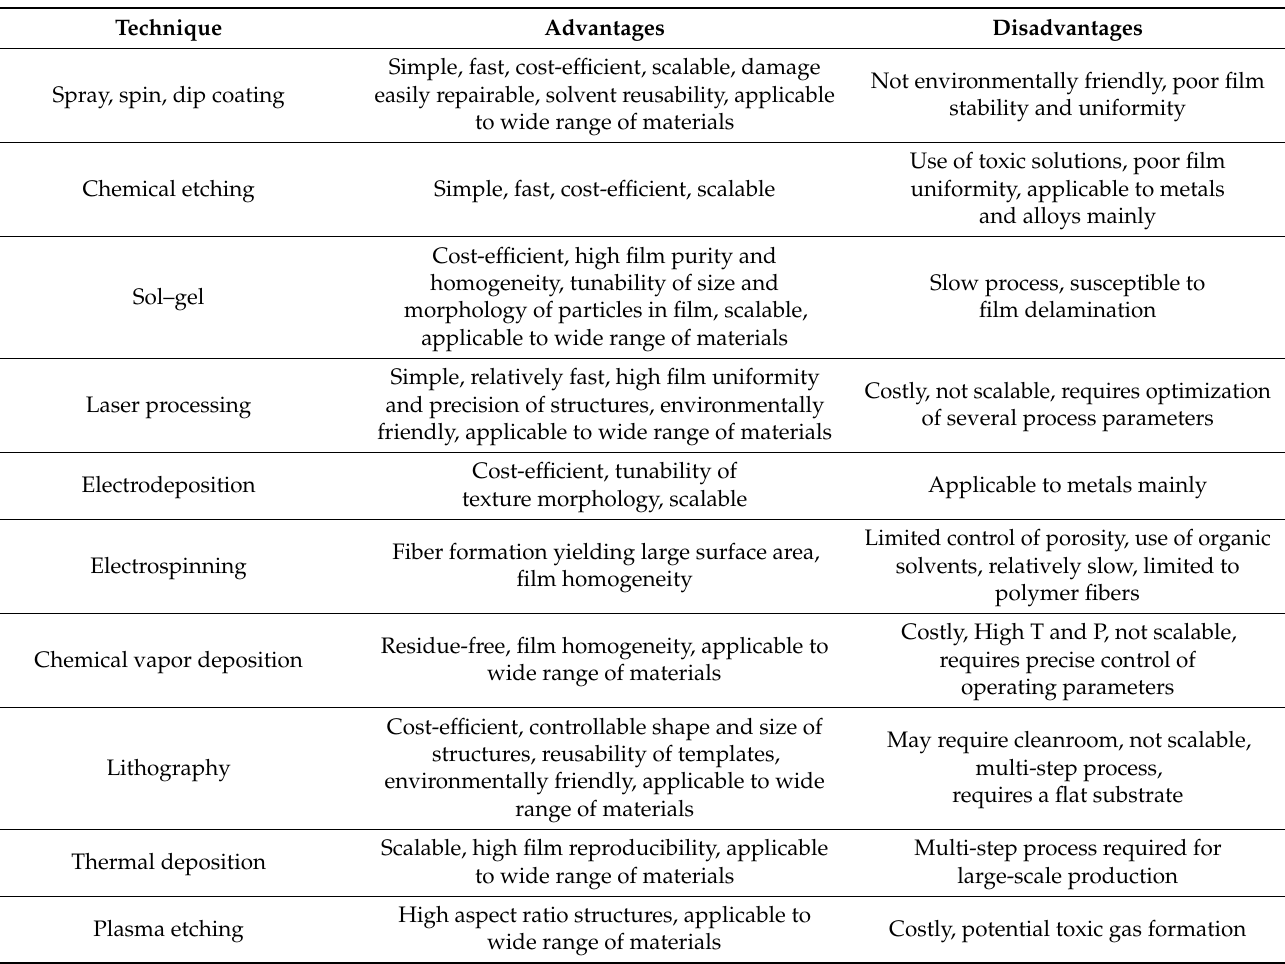
Table 1. Summary of advantages and disadvantages of the various techniques used to create super- hydrophobic